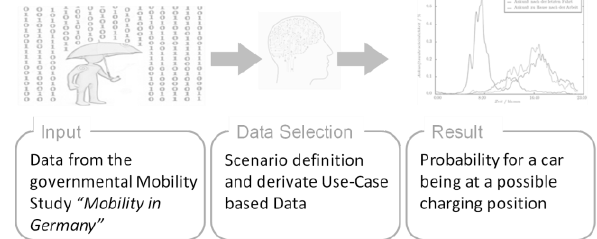
Fig. 1. Tool for generation of load curves and simultaneity factors